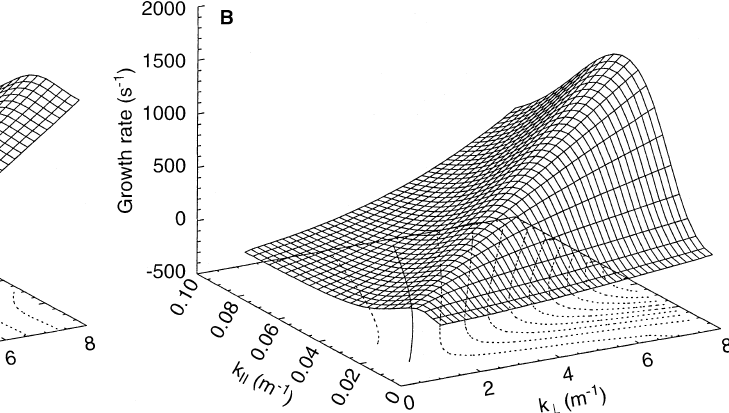
and 250 K for electron and ion temperatures, respectively, B 0 (cid:136) 50 (cid:108) T, E 0 (cid:136) 40 mV = m ; (cid:109) i (cid:136) 600 s (cid:255) 1 ; (cid:109) e (cid:136) 1 : 5 (cid:1) 10 4 s (cid:255) 1 appro- priate for an altitude of 110 km. We used an e(cid:128)ective ion mass and k ? along k corresponding to 31 amu as obtained from